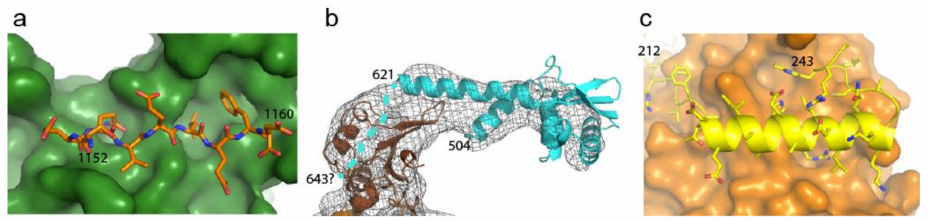
Figure 4. Protein–protein interaction sites in the E. coli replicative DNA polymerase Pol III α . ( a ). The β -clamp binding pocket bound by the Pol III α peptide. β -clamp in green, Pol III α peptide in orange sticks (PDB: 3D1F) [70]. ( b ). Cryogenic electron-microscopy (Cryo-EM) map showing Pol III α – τ